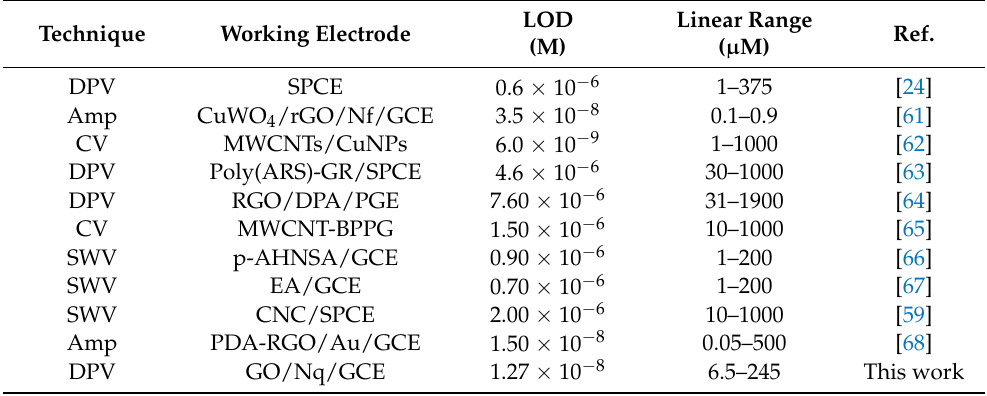
Table 1. Comparison between our detection limit with the same techniques using different work- ing electrodes.